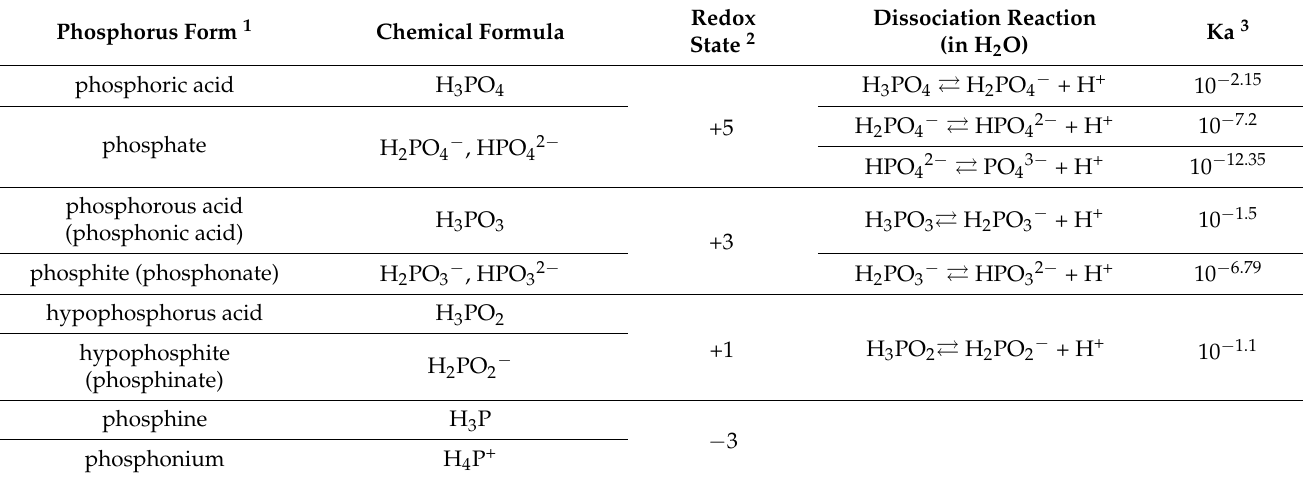
Figure 1. Structural differences between phosphate ester and phosphonate/phosphinate species. The ester contains P-O-C and the reduced phosphorus species contain P-C, where “R” represents a carbon chain of variable structures. Table 1. Common phosphorus compounds and ions in the